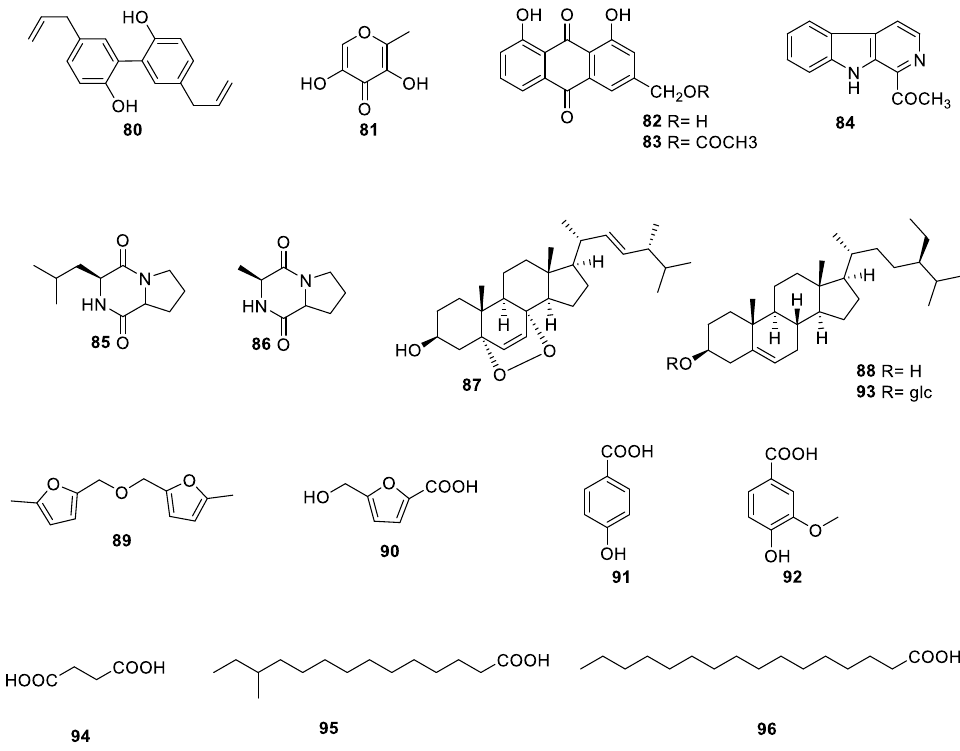
Figure 6. The structures of miscellaneous compounds from S. grosvenorii .